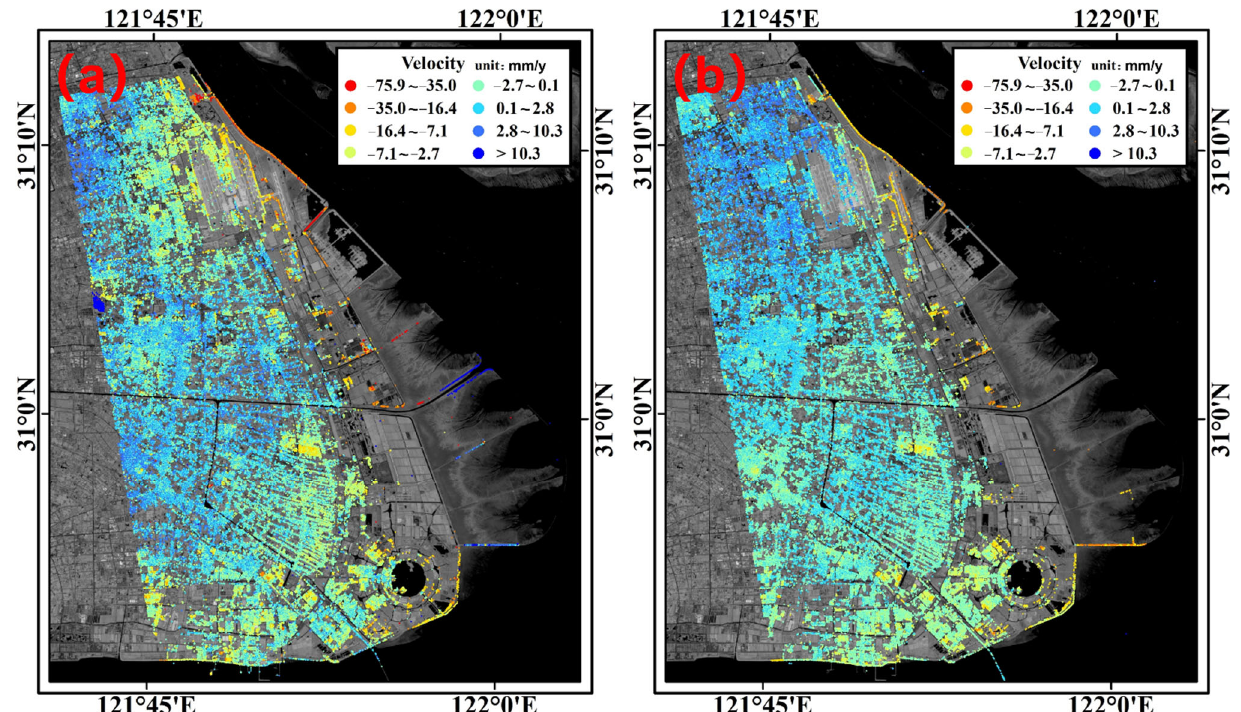
Figure 16. Deformation rates for 2016–2020 in the eastern coastal reclamation area of Shanghai: ( a )